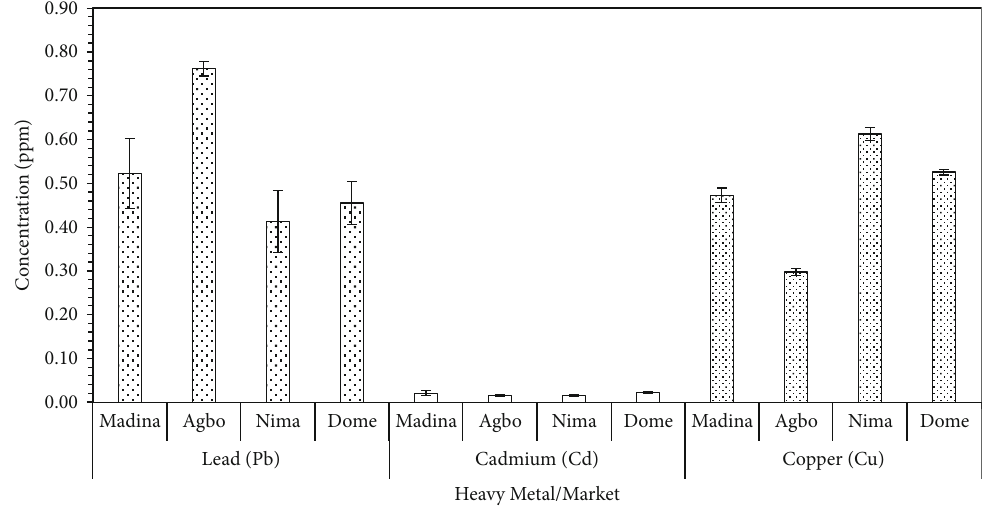
Figure 3: Levels of trace metal contaminants in melon seed powder from four